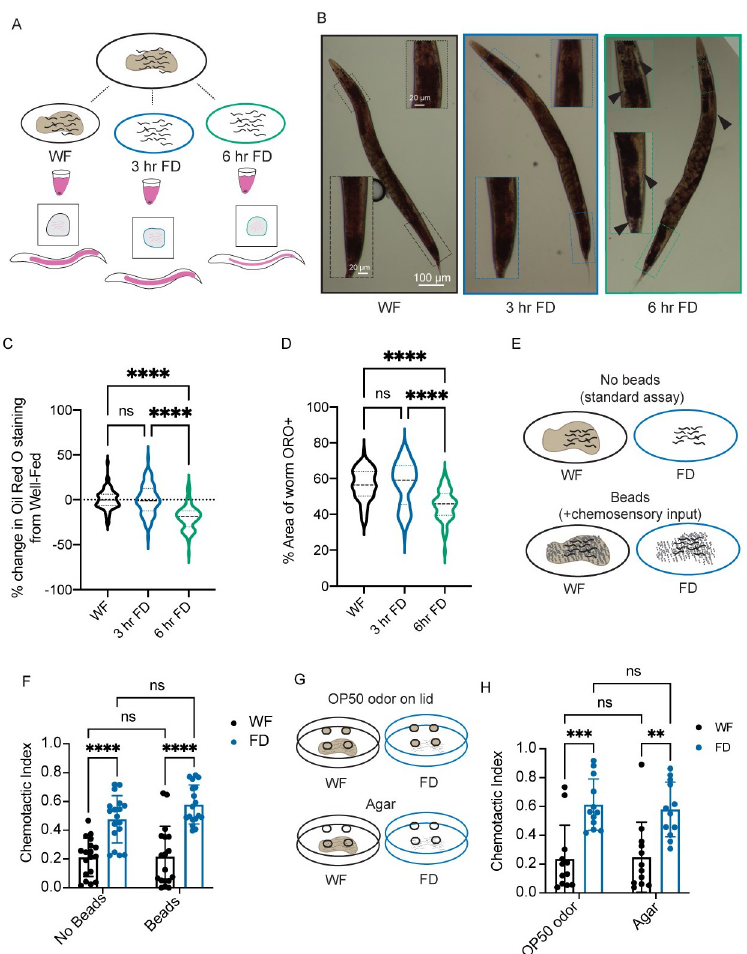
Fig 3. Lack of food, not fat or physical interactions, drive behavioral changes. (A) Schematic of Oil Red O experiments. Animals are raised together to day 1 of adulthood and separated into three groups: well-fed (on food), 3 hr food-deprived, and 6 hr food-deprived. Animals are stained using Oil Red O and then imaged using a color camera. (B) Representative images of well-fed (WF, black), 3 hour food-deprived (3hr FD, blue), and 6 hr food-deprived (6 hr FD, green). Inset images are shown, highlighting the regions where there is the most difference in staining. Black arrows highlight regions of no Oil Red O stain in 6 hr FD. (C) Graph showing the percent change in Oil Red O staining when compared to the average of the area of Oil Red O signal above a threshold value in the well-fed group within each independent experiment. N = 3, n > 20 within each experimental treatment group. (D) Graph showing the percent of the animals’ area that contains Oil Red O signal above threshold N = 3, n > 20 within each experimental treatment group. Same data as in C, shown as non-normalized values. (E) A schematic representing the experiment in F, in which populations of animals are either well-fed or food-deprived in the presence or absence of Sephadex beads before performing the sensory integration assay. (F) Prior to the sensory integration assay, animals are exposed to either standard OP50 (“no beads WF”) or empty plates (“no beads FD”), or Sephadex gel beads as chemosensory input. Alternatively, animals were exposed to beads and no food (“beads FD”) or OP50 with Sephadex beads on top (“beads WF”) for 3 hours. Animals were then exposed to standard Sensory Integration Assay set-up with 50 mM CuSO 4 and 1 μ l of 0.2% diacetyl. N � 18. (G) A schematic representing the experiment in H, in which populations of animals are either well-fed or food-deprived in the presence of OP50-containing agar plugs on the lid of the plate or agar alone plugs on the lid of the plate before performing the sensory integration assay. (H) Prior to the sensory integration assay, animals are exposed to either standard OP50 empty plates, covered with lids containing either agar plugs (agar) or agar plugs with OP50 lawns (OP50 odor) as a chemosensory input for 3 hours. Animals were then exposed to standard Sensory Integration Assay set-up with 50 mM CuSO 4 and 1 μ l of 0.2% diacetyl. N = 12 per condition. C and D were analyzed using Welch’s ANOVA test with Dunnett’s multiple comparisons test. � p < 0.5, �� p < 0.01, ��� p < 0.001, ���� p < 0.0001, ns p > 0.05. F and G were analyzed using a full model two-way ANOVA, determined to have significant differences across well-fed and food-deprived conditions but no difference between “bead”/“no bead” groups or “odor”/”agar” groups. Those comparisons are shown to indicate no difference between “beads” and “no beads”. Pairwise comparisons within each treatment were performed as t-tests with Tukey’s multiple comparisons test. Error bars are